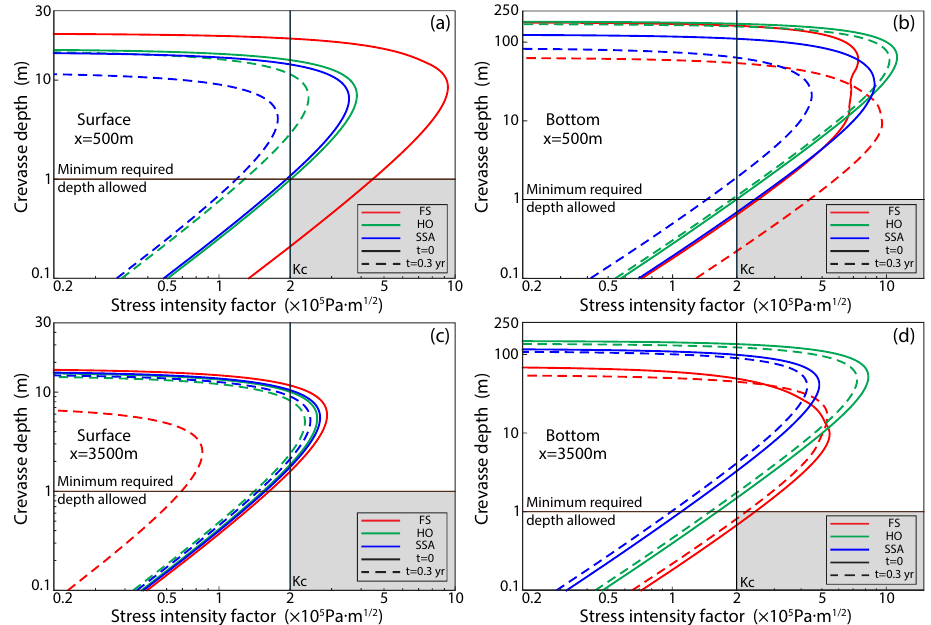
Figure 8. Stress intensity factor as a function of depth. (a) Surface crevasse with initial crevasse position at x = 500m. (b) Bottom crevasse with initial crevasse position at x = 500m. (c) Surface crevasse with initial crevasse position at x = 3500m. (d) Bottom crevasse with initial crevasse position at x = 3500m. Red, green and blue lines correspond to the FS, HO and SSA models. Solid and dashed lines correspond to the beginning and the end of each simulation. (The stress intensity factor for surface crevasse of FS at x = 500m, t = 0 . 3 years is not shown because it is negative at all depth.) The crevasse propagates when its minimum required depth is smaller than 1m (i.e., when the curve passes through the fourth quadrant).